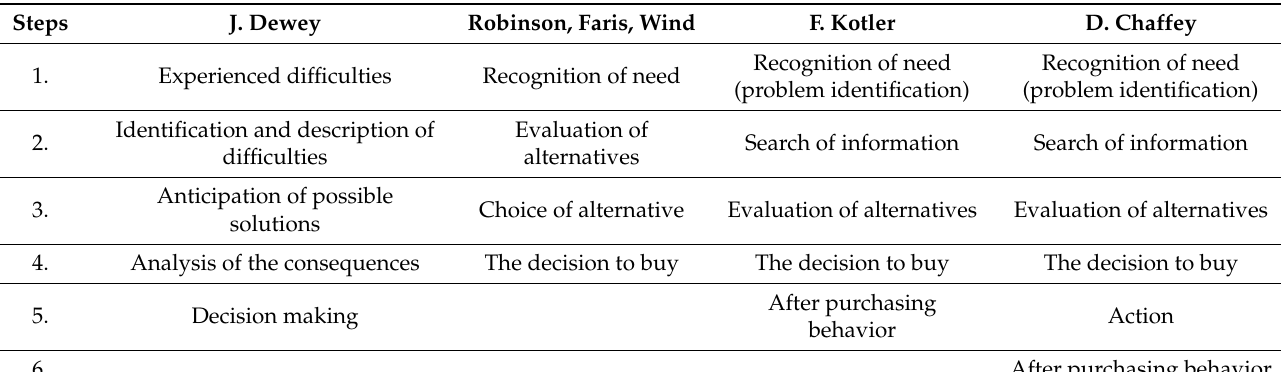
Table 1. Factors affecting decision-making process of virtual